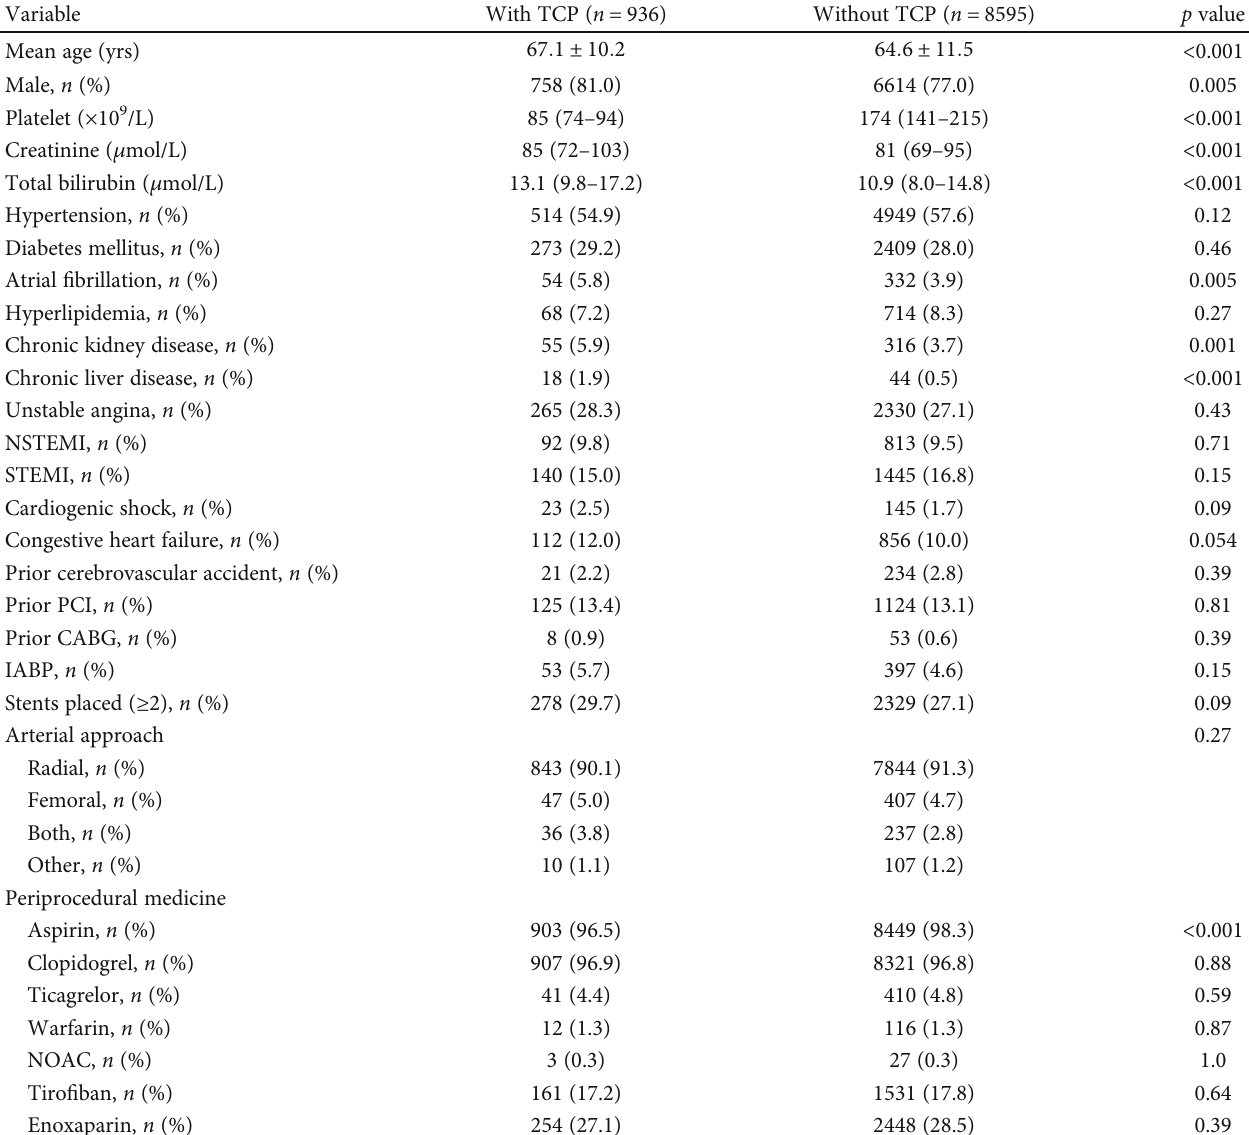
Table 1: Demographic and clinical characteristics of patients with and without